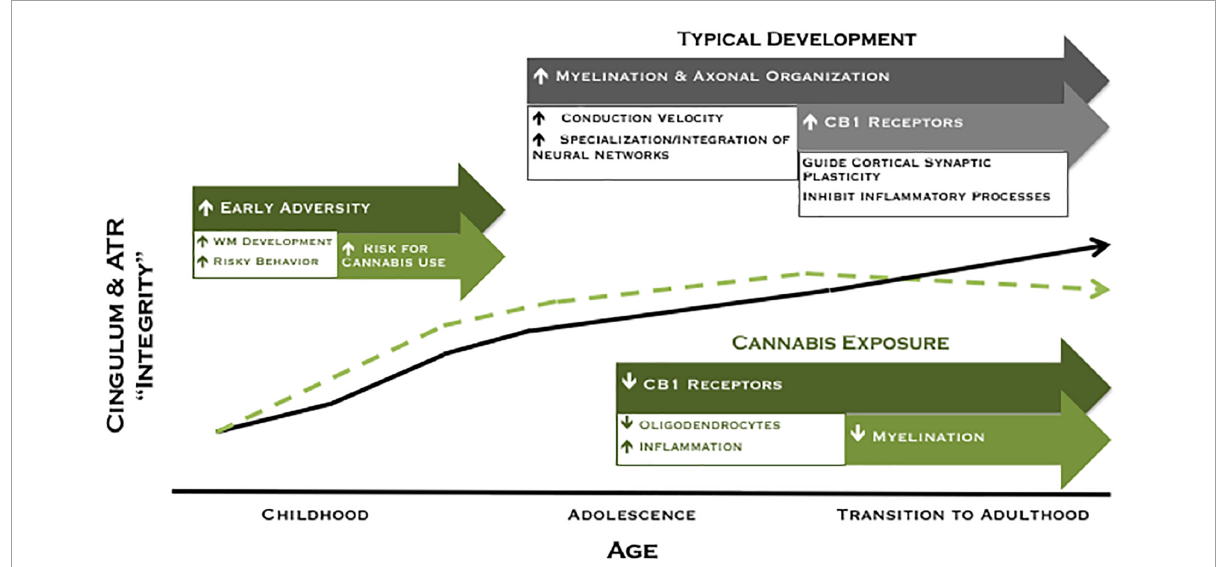
FIGURE3 Revised theoretical model of developing ACC connectivity among individuals with and without meaningful cannabis exposure. In typical development (black line), increased myelination, axonal organization, and CB1 receptor expression are postulated to give rise to increased white matter integrity across adolescence and into adulthood. Exposure to adversity early in development may lead to a compensatory acceleration of white matter development, which may increase risky behavior and risk for cannabis use among a subset of individuals (green dashed line). Conversely, cannabis exposure is associated with reduced white matter maturation of the cingulum during the transition to adulthood, an effect that may be mediated by a downregulation of CB1 receptor expression and/or direct effects on oligodendrocyte survival and